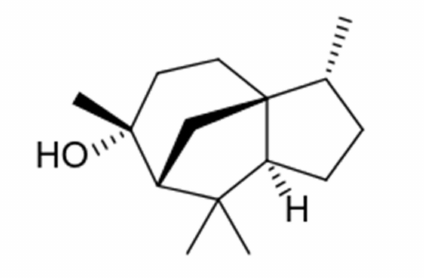
Figure 2. Chemical structure of (+)-cedrol.